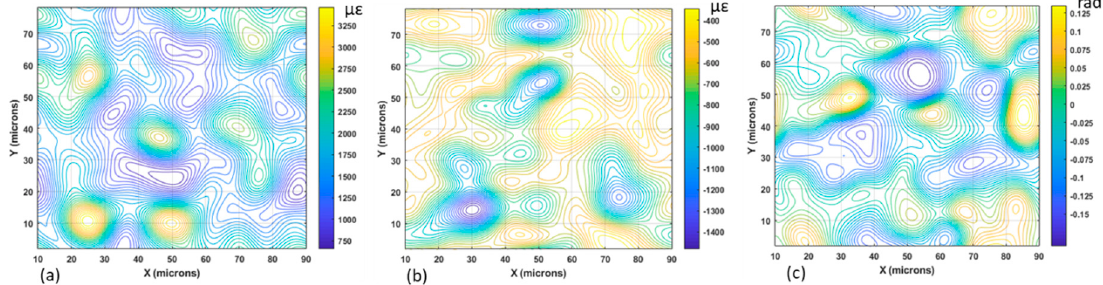
Figure 14. Al–SiC composite specimen: ( a ) Principal strain ε p1 ; ( b ) Principal strain ε p2 ; ( c ) Angle defining the direction of principal strains θ p .